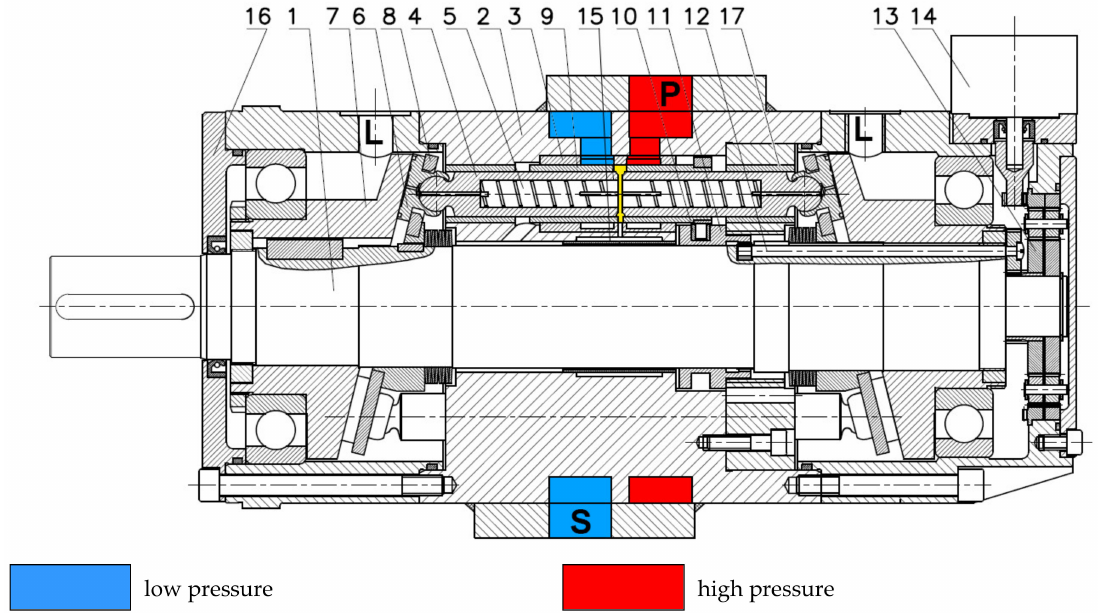
Figure 2. Axial piston pump with cam-driven commutation unit (PWK) [12]: P—high-pressure pumping channel; S— low-pressure suction channel; L—leakage channel; 1—shaft; 2—body; 3—socket; 4—piston; 5—spiral choke; 6—slipper; 7—swash-plate; 8—separator plate; 9—commutation tube; 10—cam slipper; 11—cam; 12—adjustment shaft; 13—gearbox; 14—adjustment motor; 15—compensation tube; 16—cover; 17—guiding